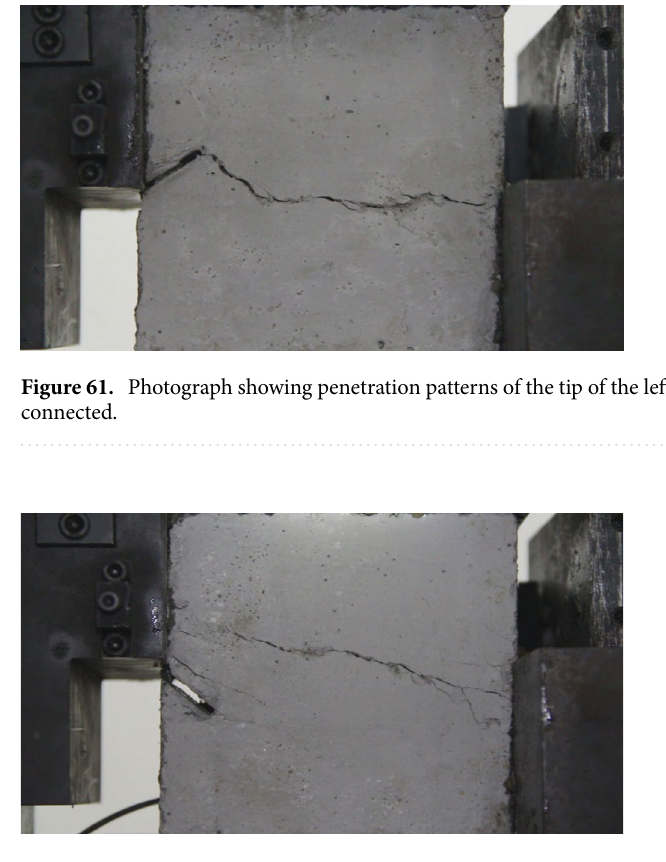
Figure 62. Photograph showing penetration patterns of the left boundary and the right boundary are